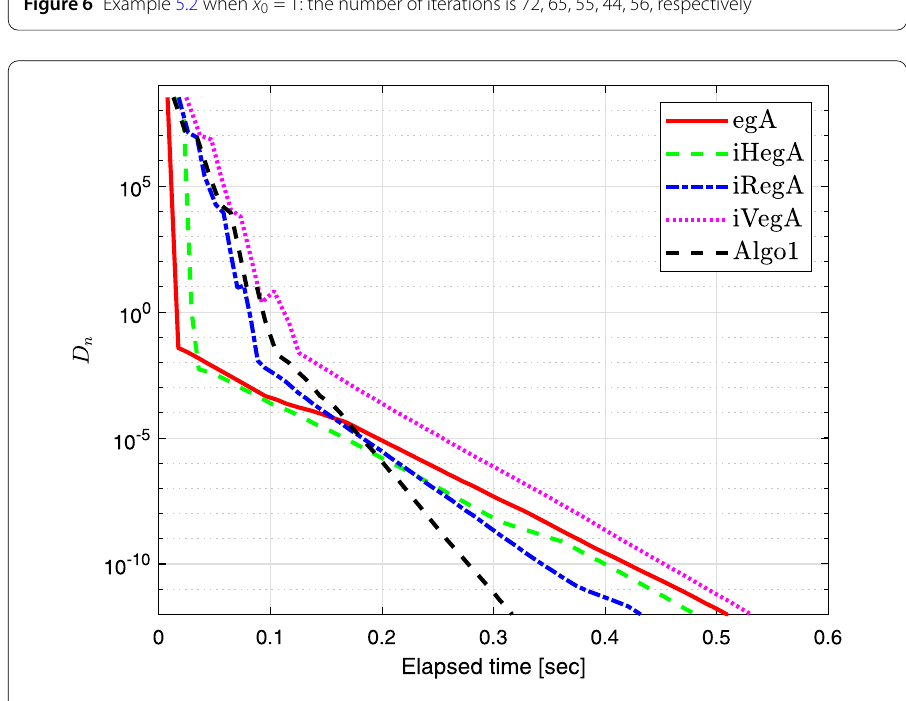
Figure 7 Example 5.2 when x 0 = t : the number of iterations is 83, 76, 69, 59, 65,